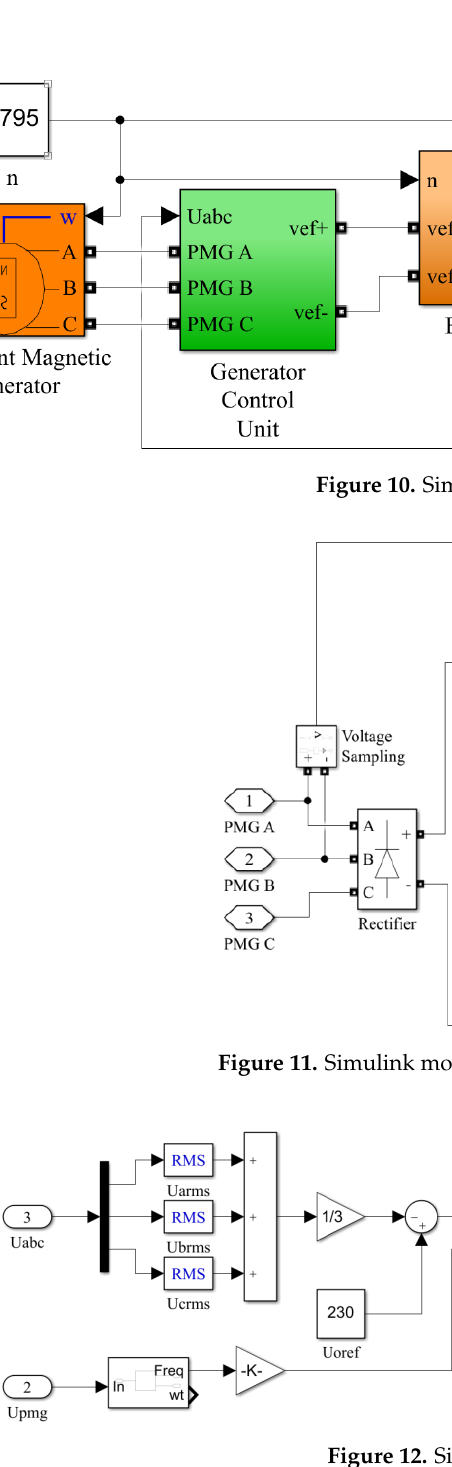
Figure 13. Simulink model of the dual fuzzy PI controller. To verify the performance of the control methods, the voltage regulator was simu- lated using three methods, a PI controller, a fuzzy PI controller, and a dual fuzzy PI con- troller. The operating points are shown in Table 1. The parameters of both the PI controller and the fuzzy PI controller were adjusted to the best performance obtained at the inter- mediate speed, namely, 8205 r/min. The dynamic performance of the three controllers was observed when the load suddenly changed at 6795 r/min and 9615 r/min, respectively. The change range of the load was between 2 kVA (10% of the rated power) and 18 kVA (90% of the rated power). The simulation results of the two rotor speeds are shown in Figures 14 and 15, respectively. Time (s) U o ( V )